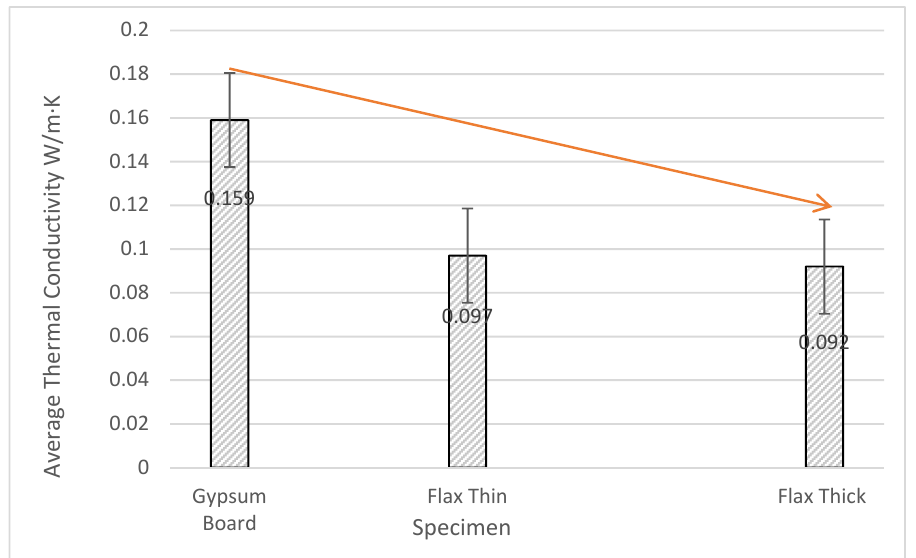
Figure 8. Average thermal conductivity of gypsum board, Flax (cid:2930)(cid:2918)(cid:2919)(cid:2924) ,and Flax (cid:2930)(cid:2918)(cid:2919)(cid:2913)(cid:2921) .